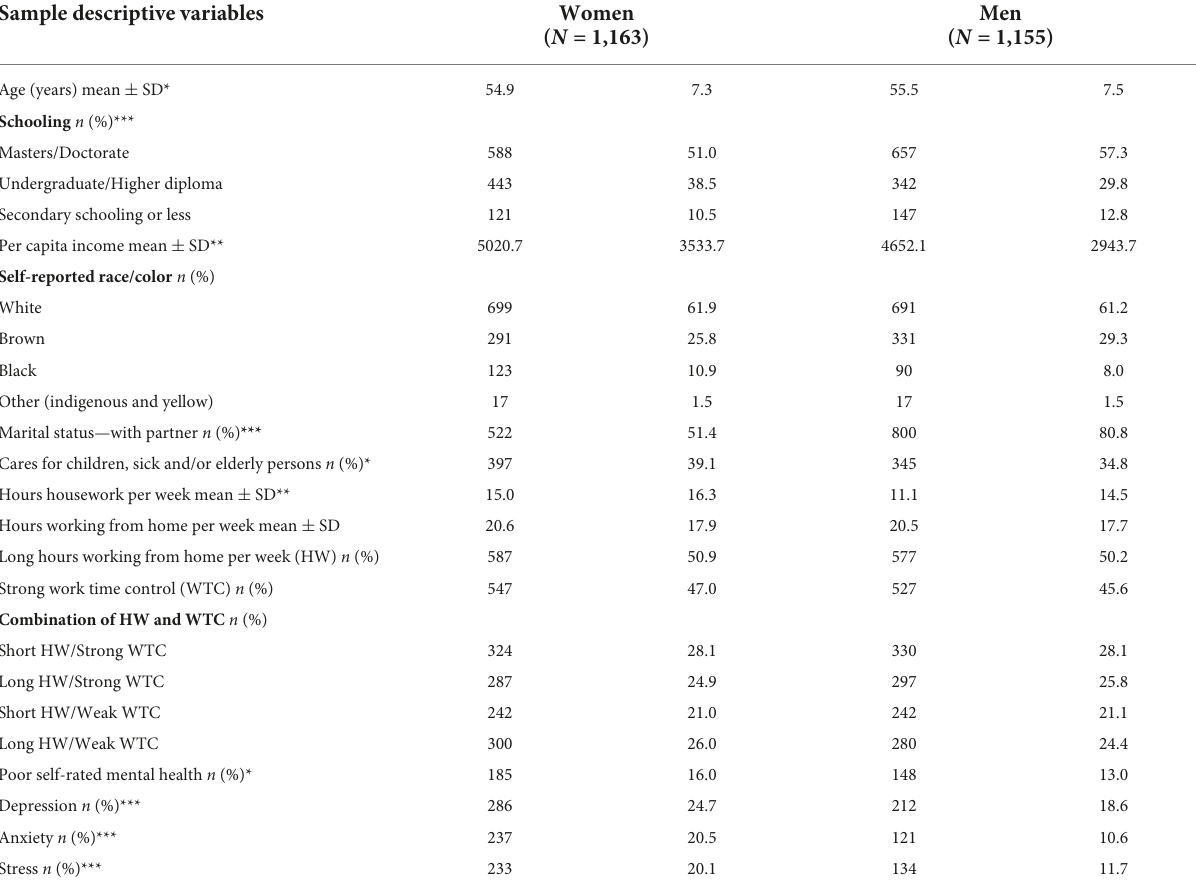
TABLE 2 Description of study variables, by